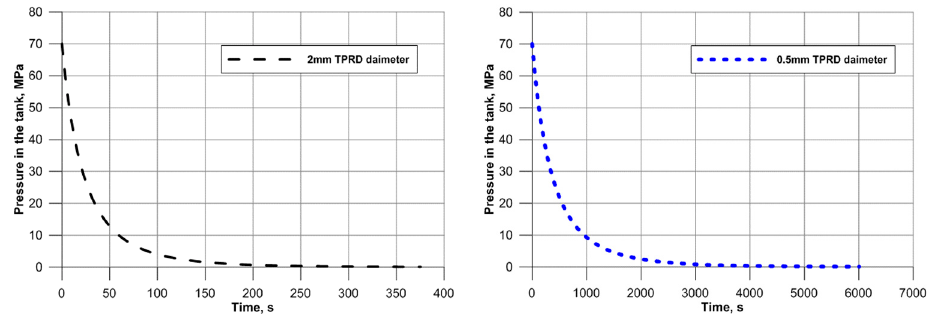
Figure 2. Pressure dynamics for adiabatic blowdown from 70 MPa, 117 L tank for 2 mm ( left ) and 0.5 mm diameter TPRD ( right ).